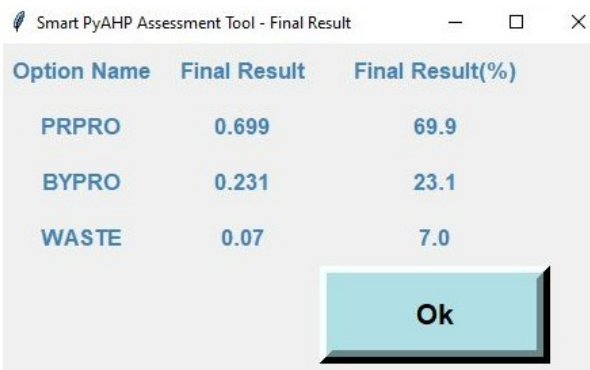
Figure 9. Generation of the preferences for all three options.